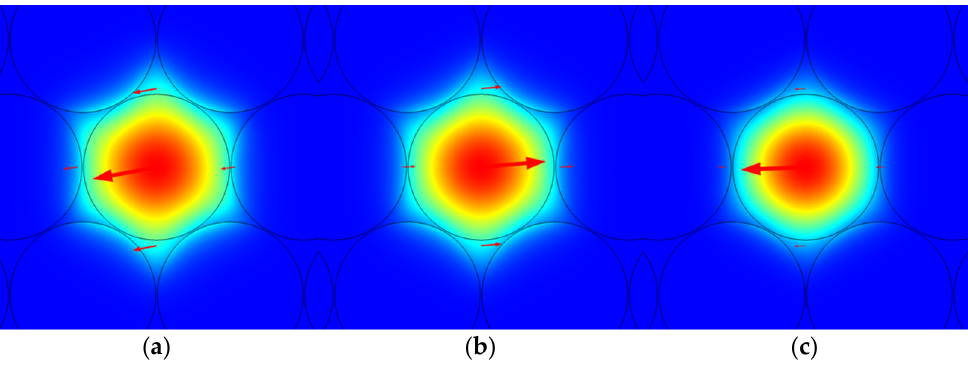
Figure 3. Mode profile of the proposed PCF with ( a ) water, ( b ) ethanol and ( c ) benzene, at wavelength of 1.0 µ m.